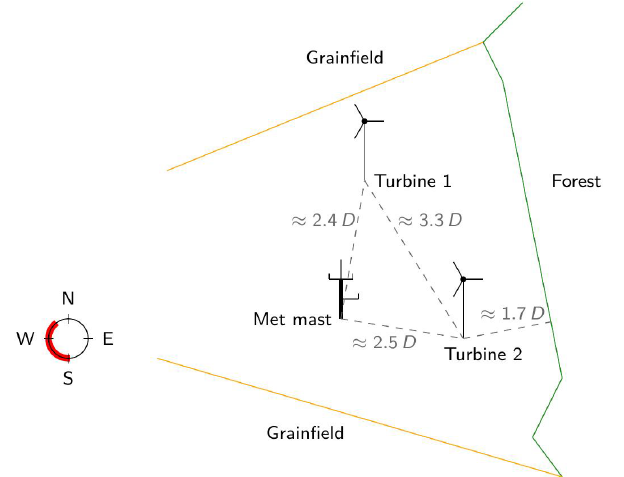
Figure 5. Schematic of the measurement site in Brusow. The re- maining wind directions in the measurement data, after filtering, are indicated in red; D is the turbine diameter, here D = 114 .